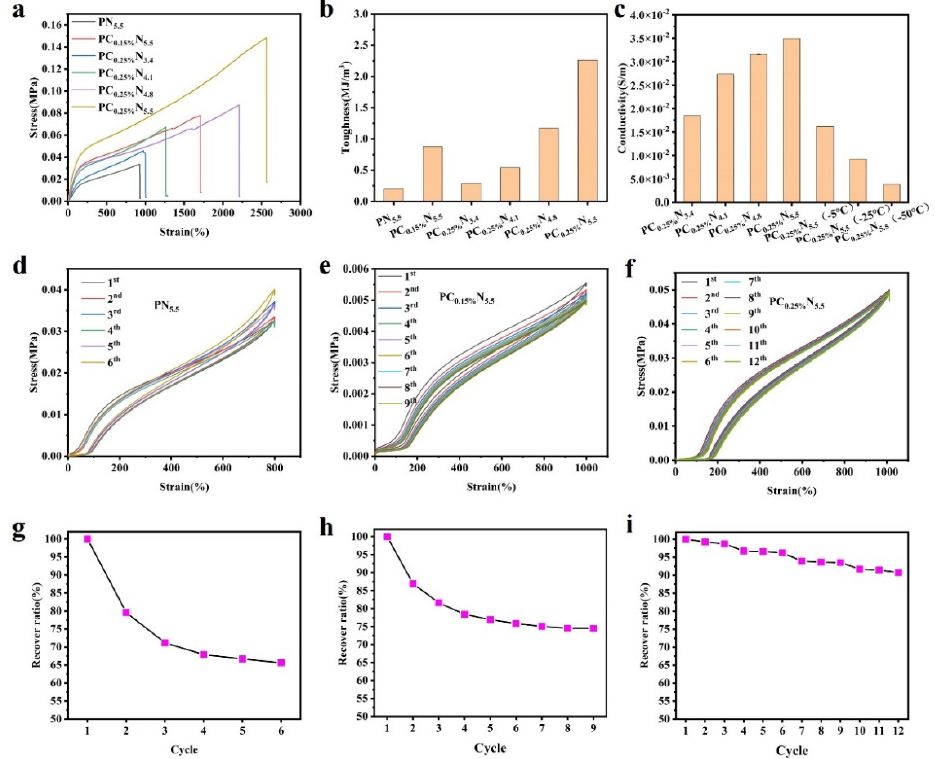
Figure 2. Properties of the nanocellulose composite hydrogel. ( a ) Tensile strain curves of different hydrogels. ( b ) Toughness of different hydrogels. ( c ) Ionic conductivity of different hydrogels. ( d ) Repetitive loadingunloading stress—strain curve of the PN 5.5 hydrogel for 6 cycles (the inset shows the corresponding recovery ratio for each cycle). ( e ) Repetitive loading—unloading stress— strain curve of the PC 0.15% N 5.5 hydrogel for 9 cycles (the inset shows the corresponding recovery ratio for each cycle). ( f ) Repetitive loading—unloading stress—strain curve of the PC 0.25% N 5.5 hydrogel for 12 cycles (the inset shows the corresponding recovery ratio for each cycle). ( g ) The PN 5.5 hydrogel repeated loading—unloading stress—strain recovery ratio. ( h ) The PC 0.15% N 5.5 hydrogel repeated loading—unloading stress—strain recovery ratio. ( i ) The PC 0.25% N 5.5 hydrogel repeated loading—unloading stress—strain recovery